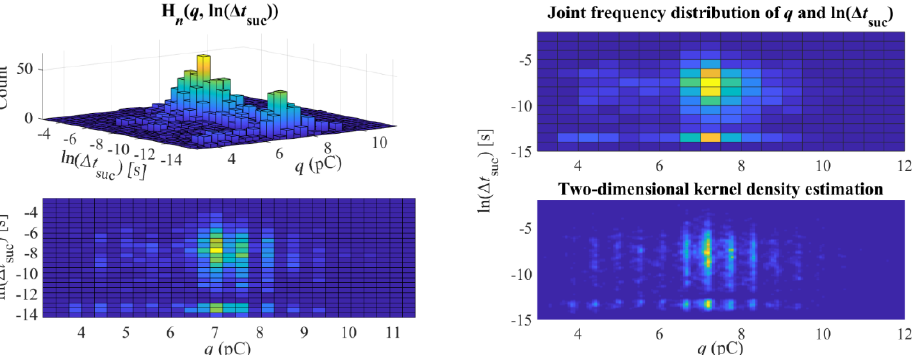
Figure 4. The illustration of H n ( q , ln( ∆ t suc )) and the corresponding result of two − dimensional kernel density estimation.